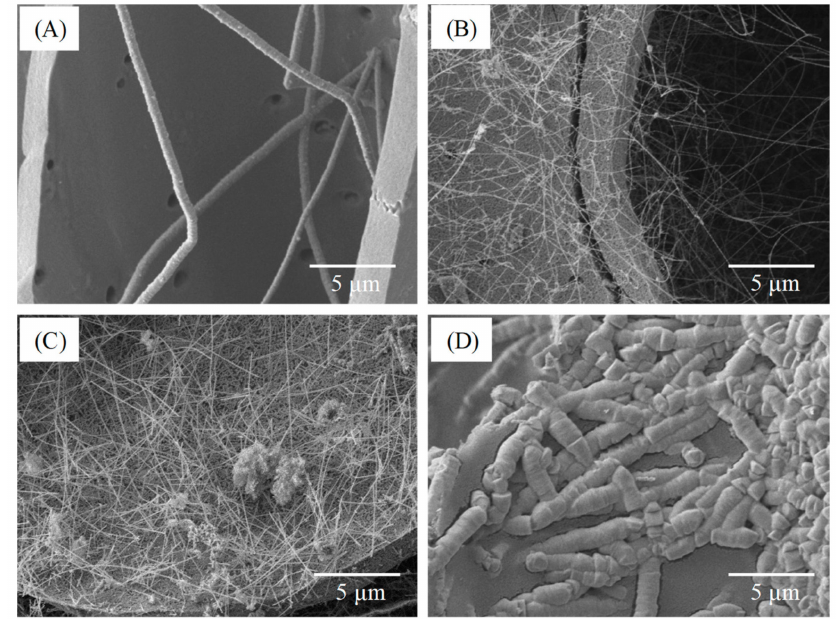
Figure 5. SEM micrographs of BcSiCs sintered at 1700 ◦ C for 0.5 h ( A ), 1 h ( B ), 2 h ( C ), and 3 h ( D ).